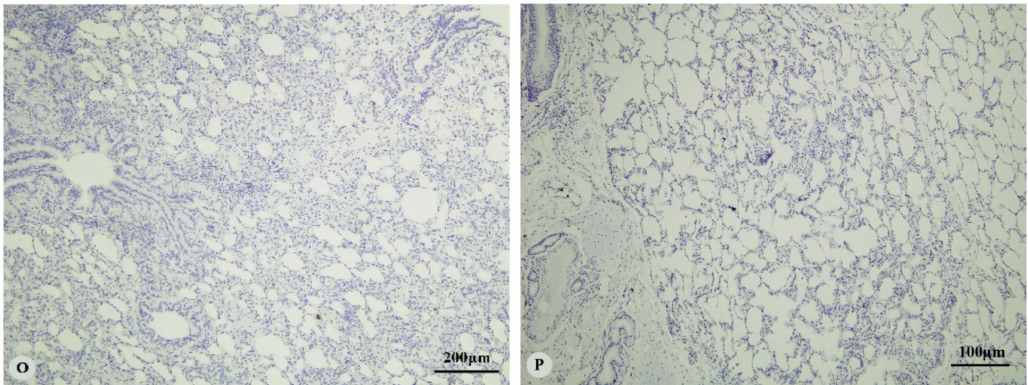
Figure 2. Immunostaining of four proteins in the lung of two-year-old Tibetan sheep. ( A – C ): Hypoxia-inducible factor (HIF)-1 α immunostaining in the lung; ( D – F ): HIF-2 α immunostaining in the lung; ( G–I ): HIF-3 α immunostaining in the lung; ( J–L ): Vascular endothelial growth factor (VEGF) immunostaining in the lung; ( M–P ): control of HIF-1 α , HIF-2 α , HIF-3 α and VEGF in lung, respectively. Arrows in ( C , F , I , L ): HIF-1 α , HIF-2 α , HIF-3 α and VEGF immunostaining in alveolar macrophages, respectively. The positive immunostaining was brown with non-immunostaining nuclei blue. ( A , D , G , J , M , O , P ): 20 × ; ( B , C , E , F , H , I , K , L , N ): 100 × ).